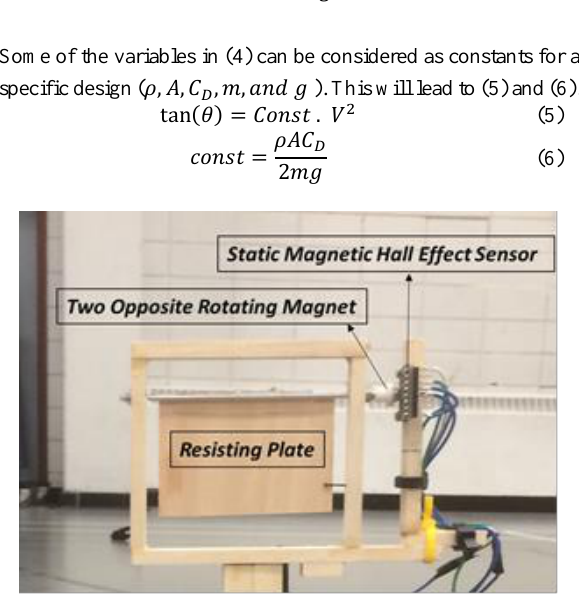
Figure 1. Air-Odo design using Hall-Effect sensor (static and rotating part) and resisting plate.